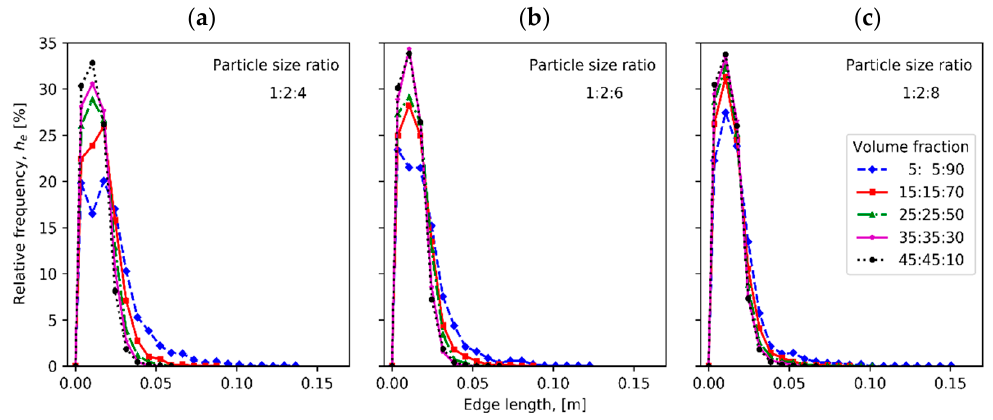
Figure 5. Relative frequency of edge length of radical Voronoi cells for samples having different volume fractions and three instances of particle size ratio: ( a ) 1:2:4, ( b ) 1:2:6 and ( c ) 1:2:8.